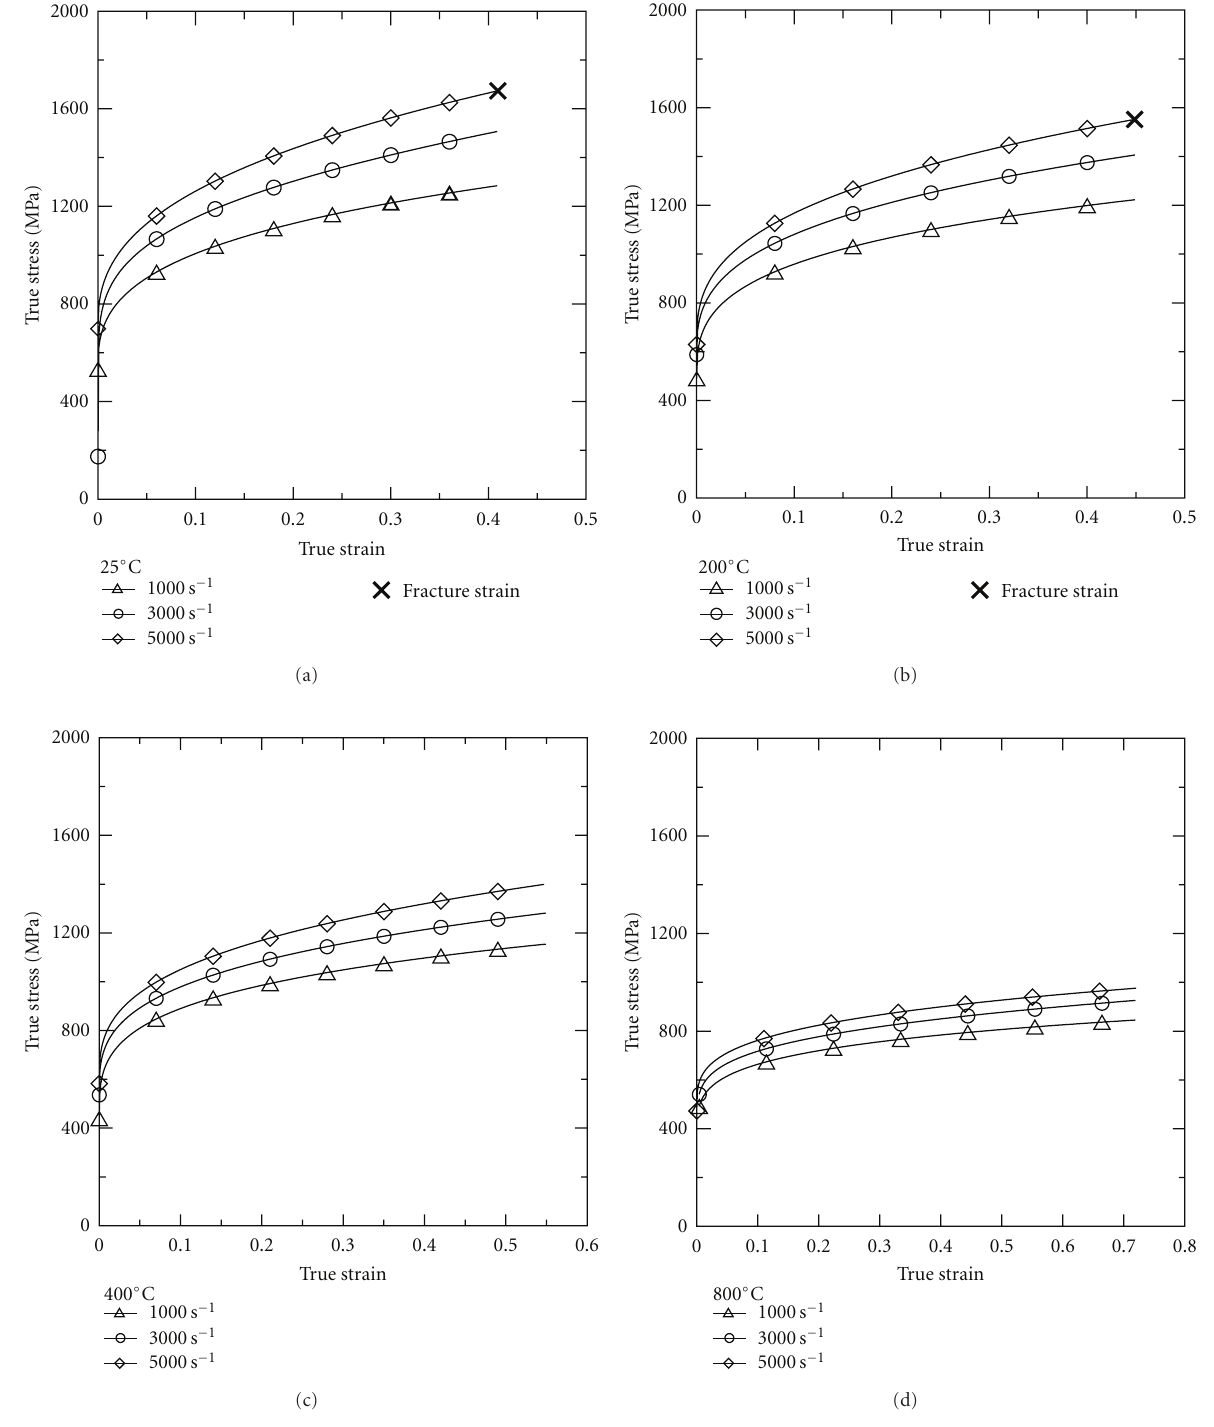
Figure 2: True stress-strain curves of 316L stainless steel deformed at di ff erent strain rates and temperatures of (a) 25 ◦ C; (b) 200 ◦ C; (c) 400 ◦ C; (d) 800 ◦